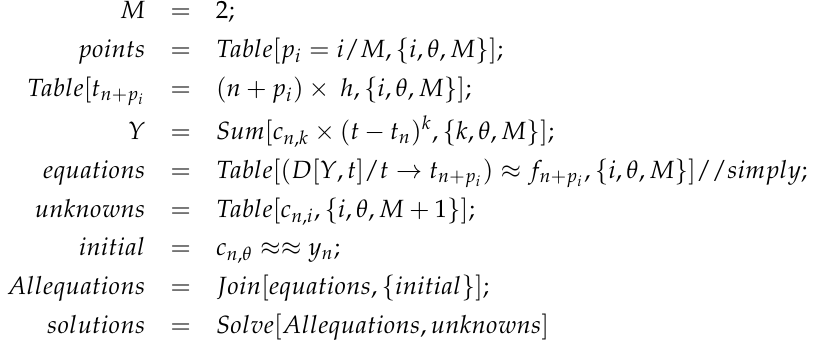
) ≈ f { i , θ , M } ] // simply ; n + p i , i